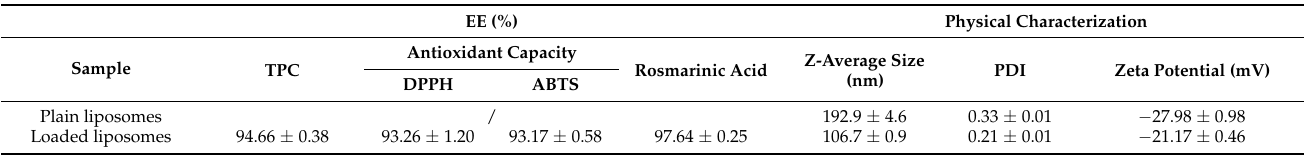
Table 4. Encapsulation efficiency (EE) and physical characterization of liposomes. EE